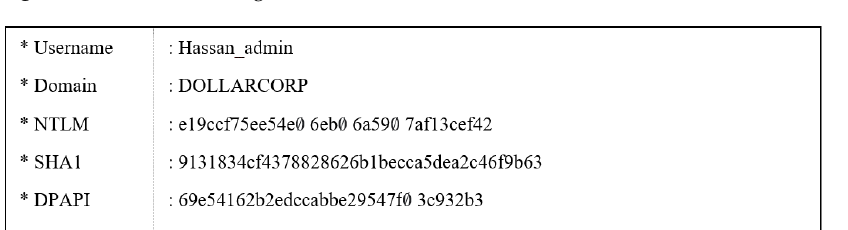
Figure 9. Elevated Privileges on Mimikatz.